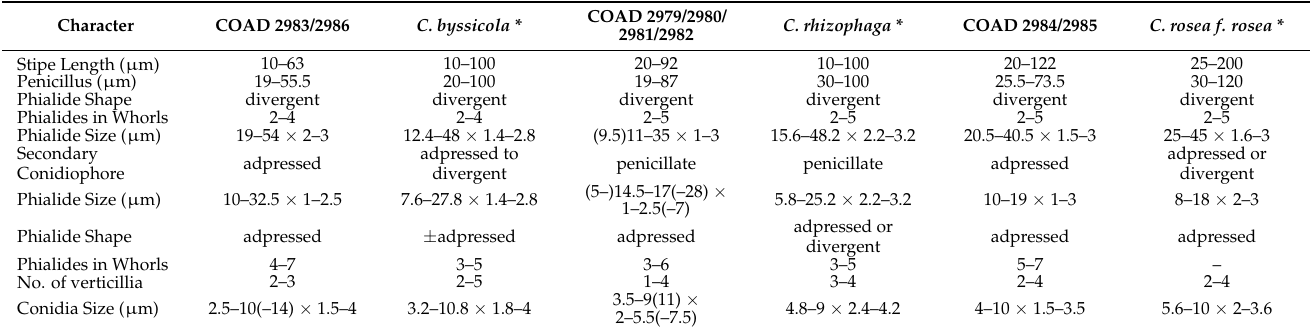
Table 2. Morphologies of Clonostachys isolates from coffee and Hemileia vastatrix and earlier published descriptions of Clonostachys spp. included in the phylogenetic tree.